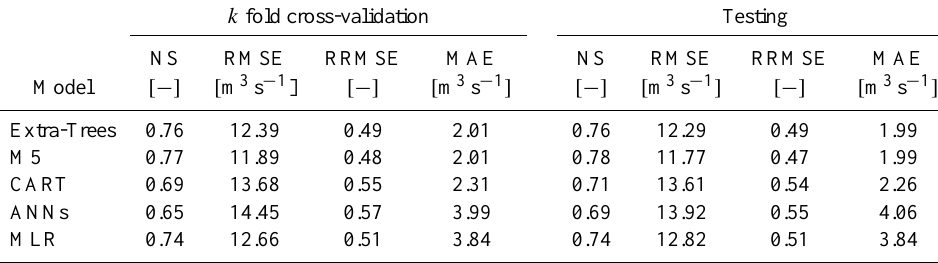
Table 6. k -fold cross-validation (with k =10) and testing results of Extra-Trees and benchmarking models for Marina Catchment dataset. k fold